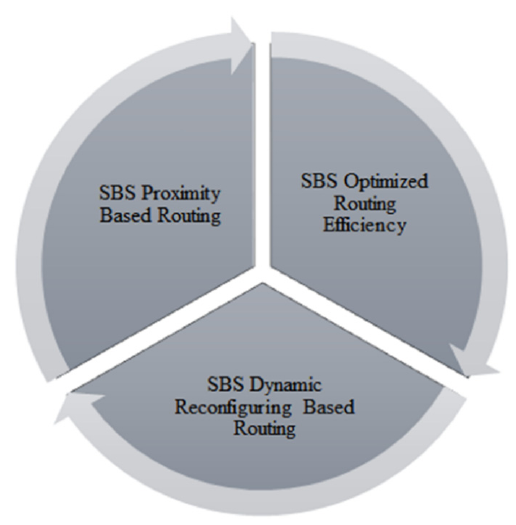
Figure 5. The categorization of service broker policies [14]. Table 3. Pros and cons of service broker policies in cloud computing environments. Policy Pros and Cons